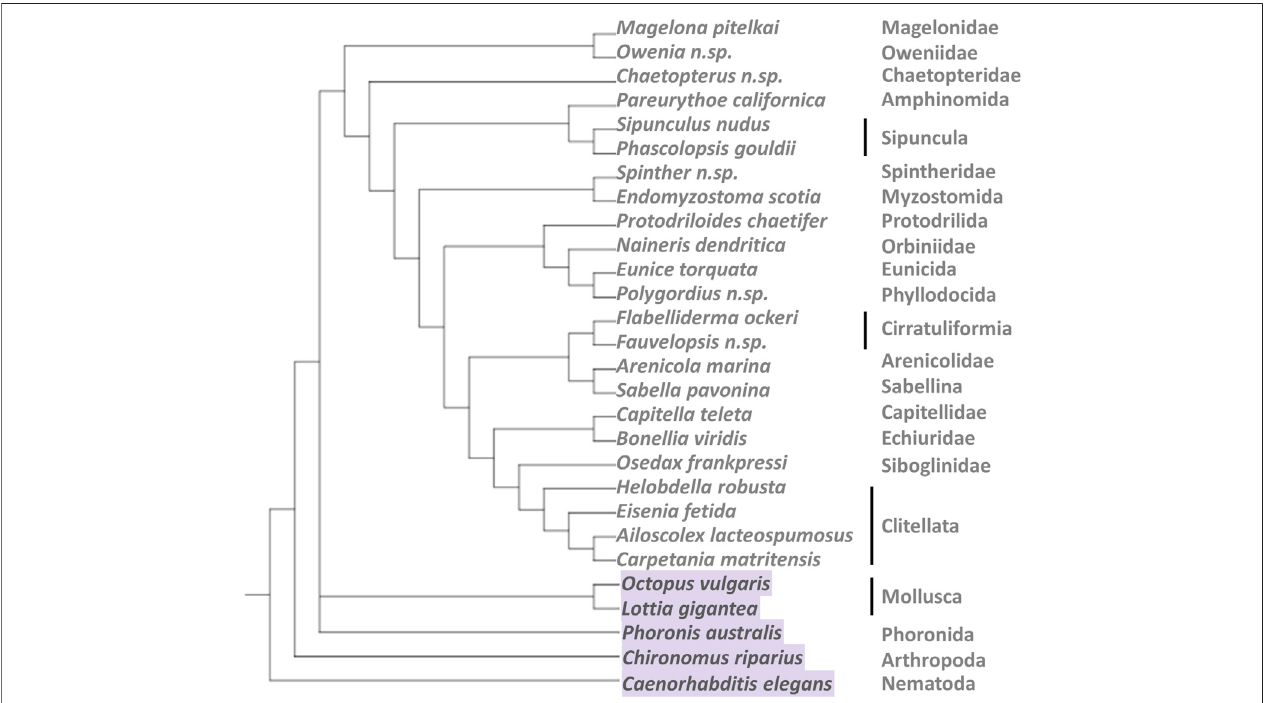
FIGURE 1 | Tree modi fi ed from Figure 5 in Andrade et al. (2015) including the species covered in this study. Note that some of the internal relationships of the annelids are not yet well resolved, so this fi gure only gives an overview of the diversity covered within the group.